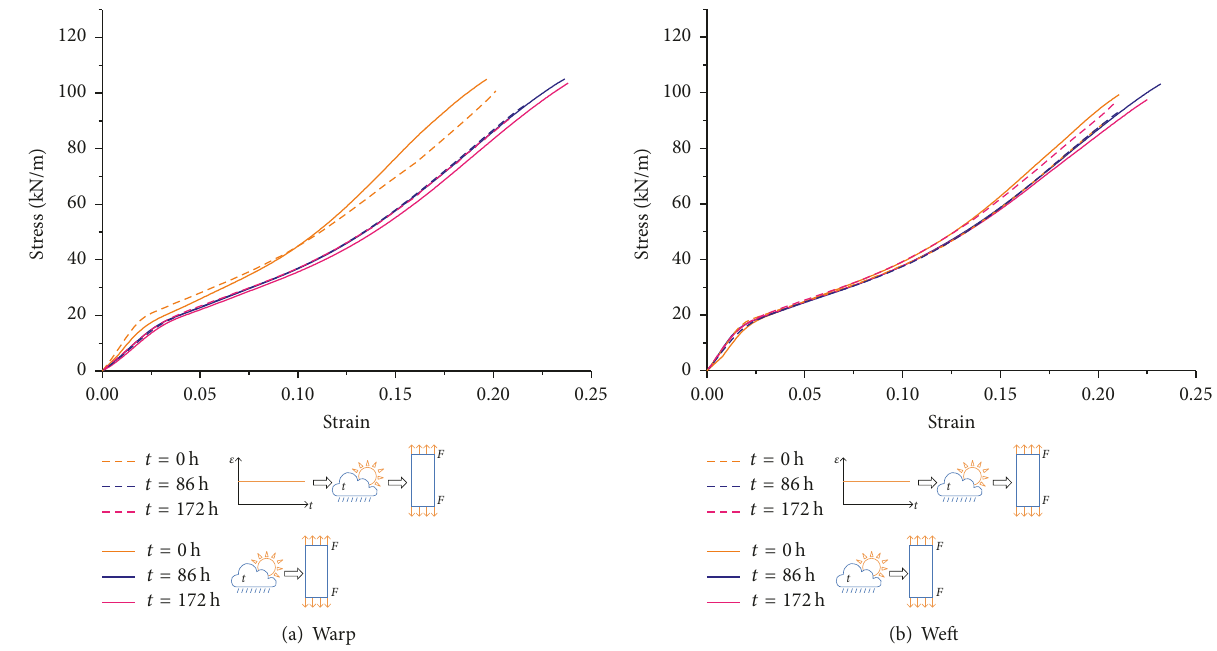
Figure 9: Tensile curves of different materials (after or without relaxation) after aging.